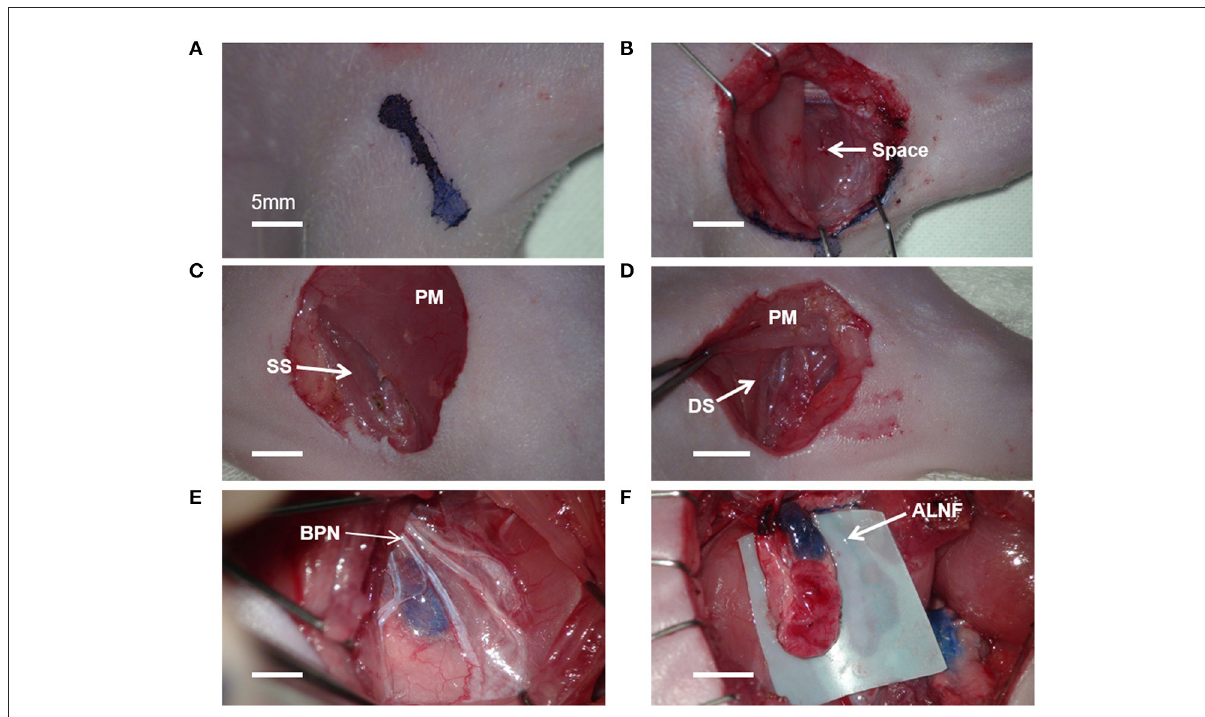
FIGURE1 Microsurgical procedure for axillary lymph node flaps (ALNFs). (A) Axillary incision, 1–1.5cm. (B) The space between the proximal forelimb and lateral chest. (C) Dissecting approach to the superficial surface (SS) of the pectoralis major (PM). (D) Dissecting approach to the deep surface (DS) of the PM. (E) The branches of the brachial plexus nerve (BPN), exposed above the ALNF. (F) Complete elevation of the ALNF.